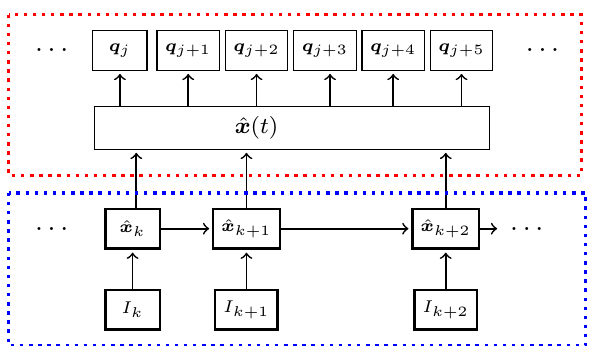
Figure 4: Timing of state estimates x k in the camera rate (blue box) and the desired joint variables q j in the robot controller rate (red